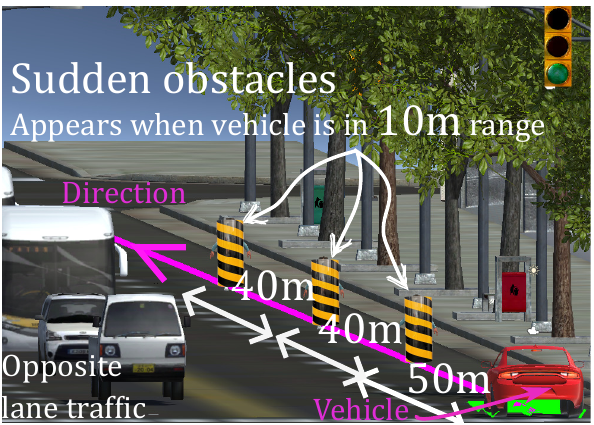
Figure 12. Scenario 2: Sudden obstacle avoidance in urban